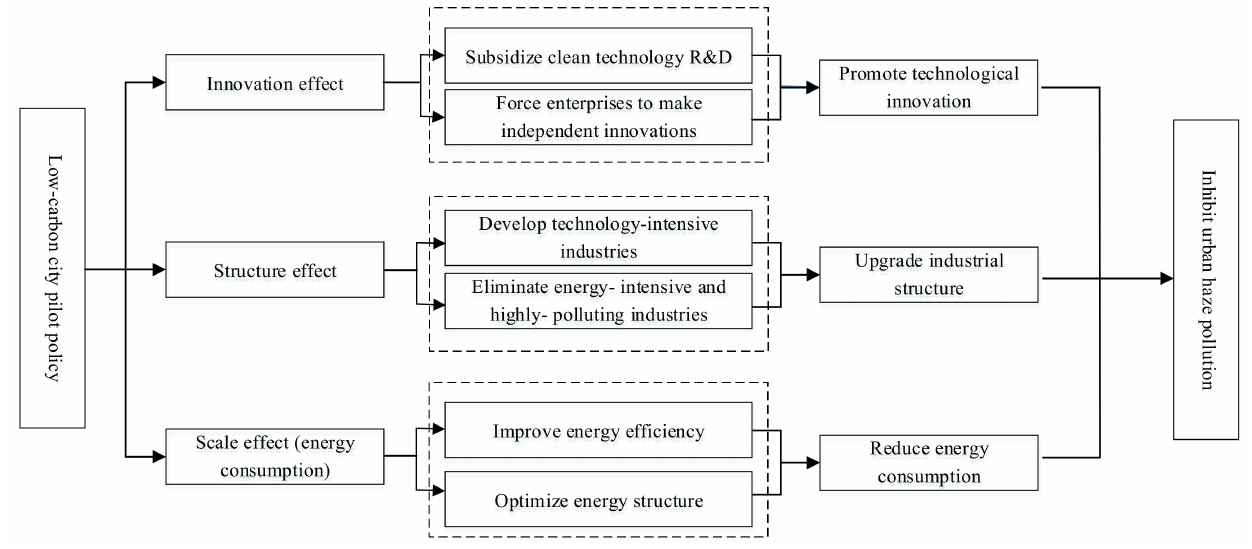
Figure 3. Mechanism diagram of the impact of LCCP on haze